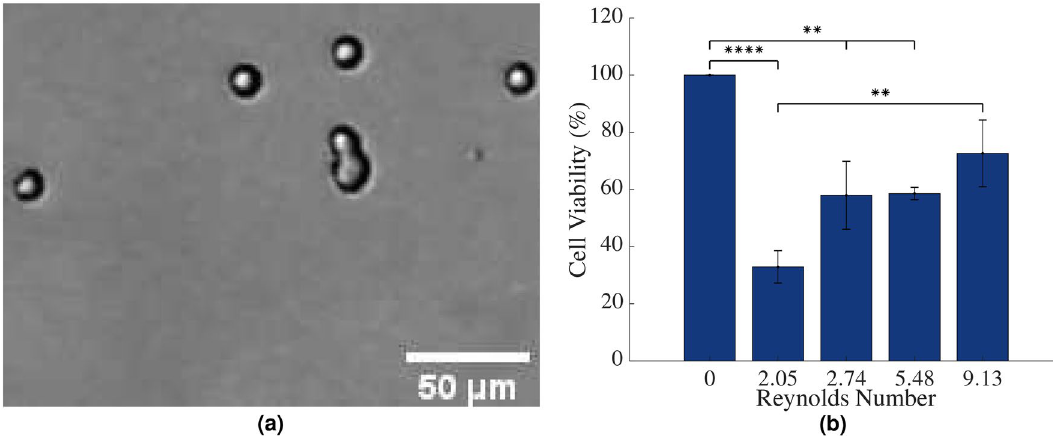
Figure 4. (a) SH-SY5Y neuroblastoma cells following suspension in Poiseuille flows of Re = 2.74 for 24 h, stained with trypan blue. (b) The viability of SH-SY5Y neuroblastoma cells in circulation, assessed using MTT assay. Statistical analysis was conducted using two-way ANOVA. Results were normalised to static cells in suspension (or Re of 0). **** p < 0.0001, ** p < 0.01, n = 3 replicates, vertical bars represent the